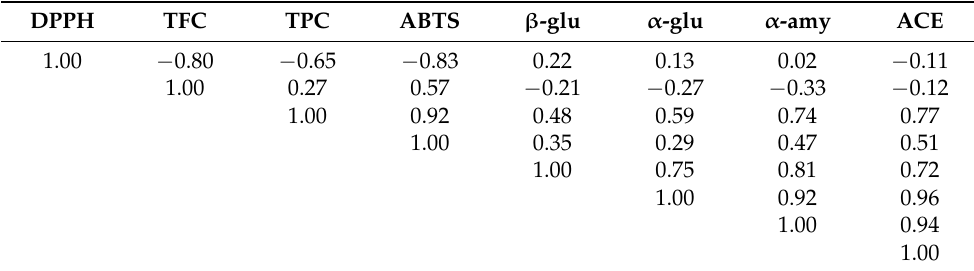
Figure 4. In vitro inhibitory activities (of the selected fruits samples towards ( A ) antidiabetic- ( α - amylase — 83 μ L extract / 1 U, α - and β -glucosidase — 500 μ L extract / 1 U) and ( B ) antihypertensive- (ACE — 8 μ L extract / 1 U)) model enzymes. For legend simplification, fruits sections were organized by colors: pitanga seeds and pulp in light and dark blue, respectively, tangerine peel and juice in yellow, and light orange, respectively, lemon peel and juice in light and dark green, respectively. Legend: ACE—Angiotensin-converting enzyme. Table 1. Pearson correlation coefficients between phenolic composition, antioxidant capacity and selected enzymes inhibition for the fruit extracts analysed in this